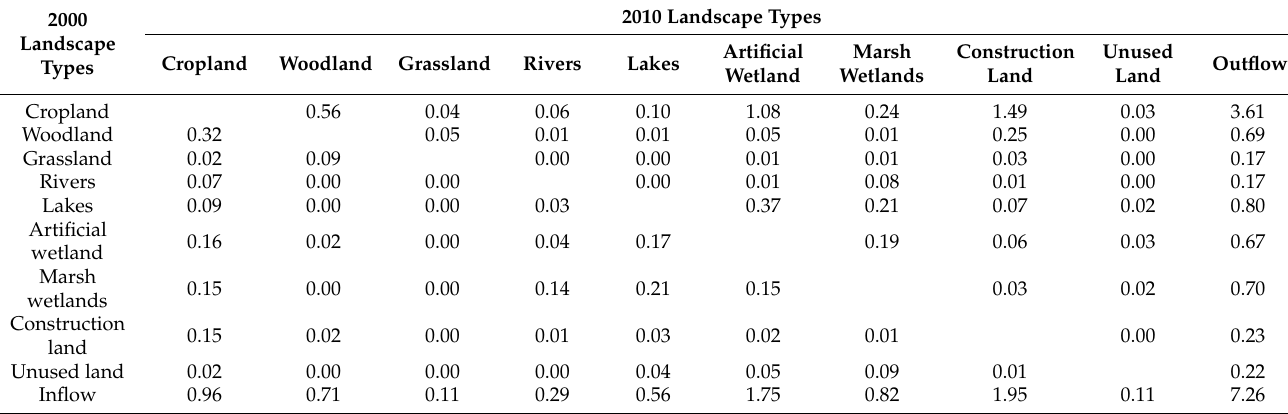
Table 1. Landscape flow transfer matrix, 2000–2010 (unit: